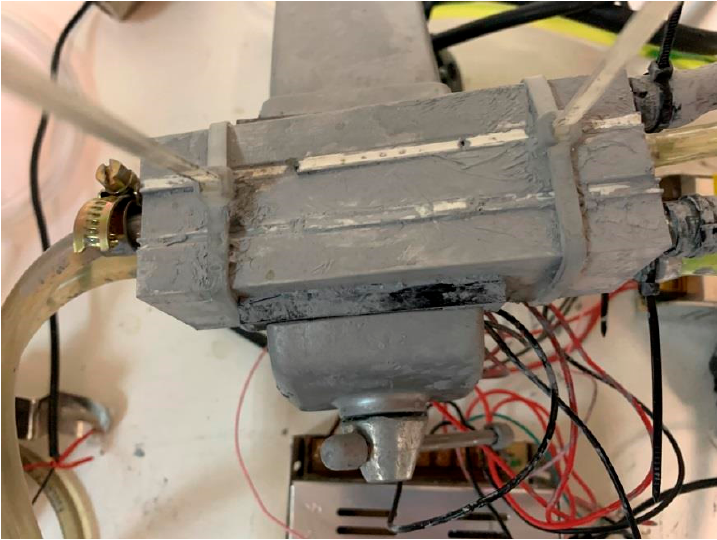
Figure 4. The aluminum blocks are attached to the thermoelectric modules from both sides of cooling block.